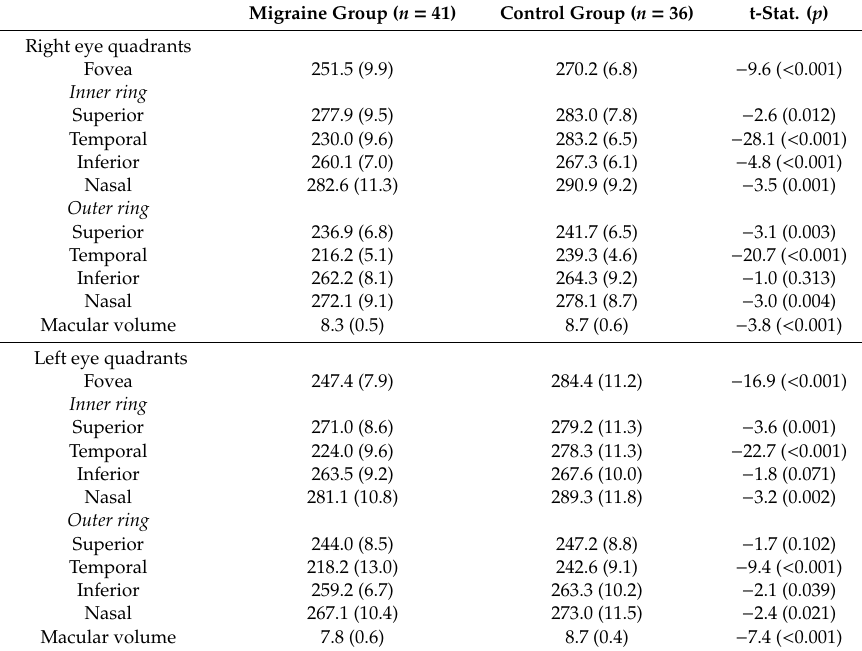
Table 3. Macular retinal nerve fiber layer (RNFL) thickness ( µ m) analysis by